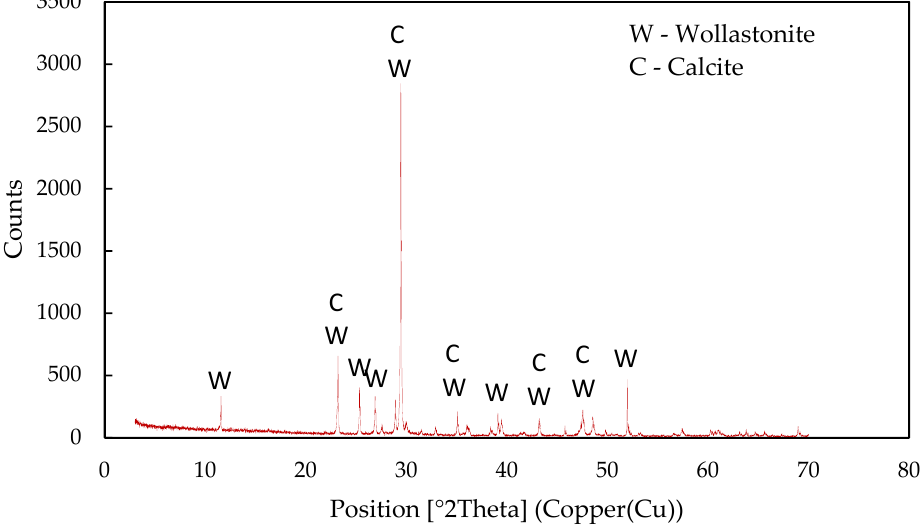
Figure 2. X-ray diffraction patterns of the wollastonite-calcite sample.